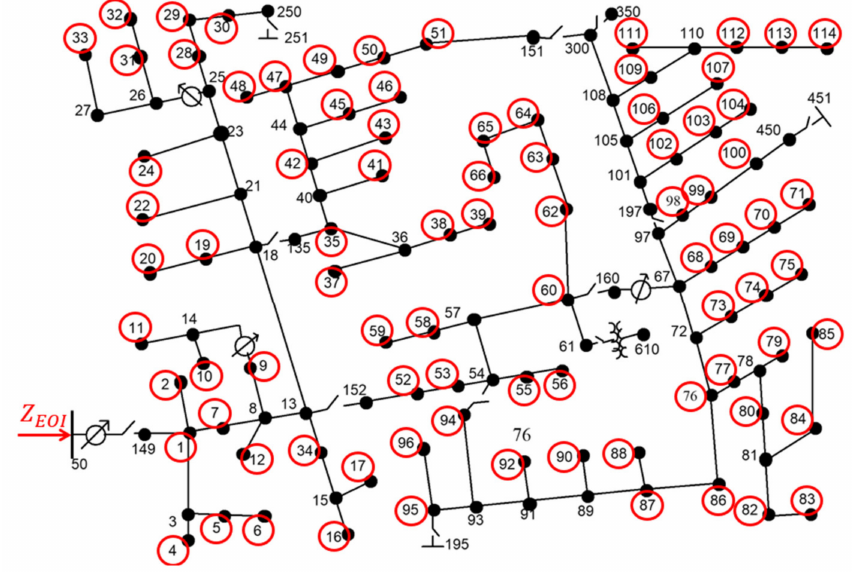
Figure 6. Allocation of non-technical losses in IEEE- 123 system [30].